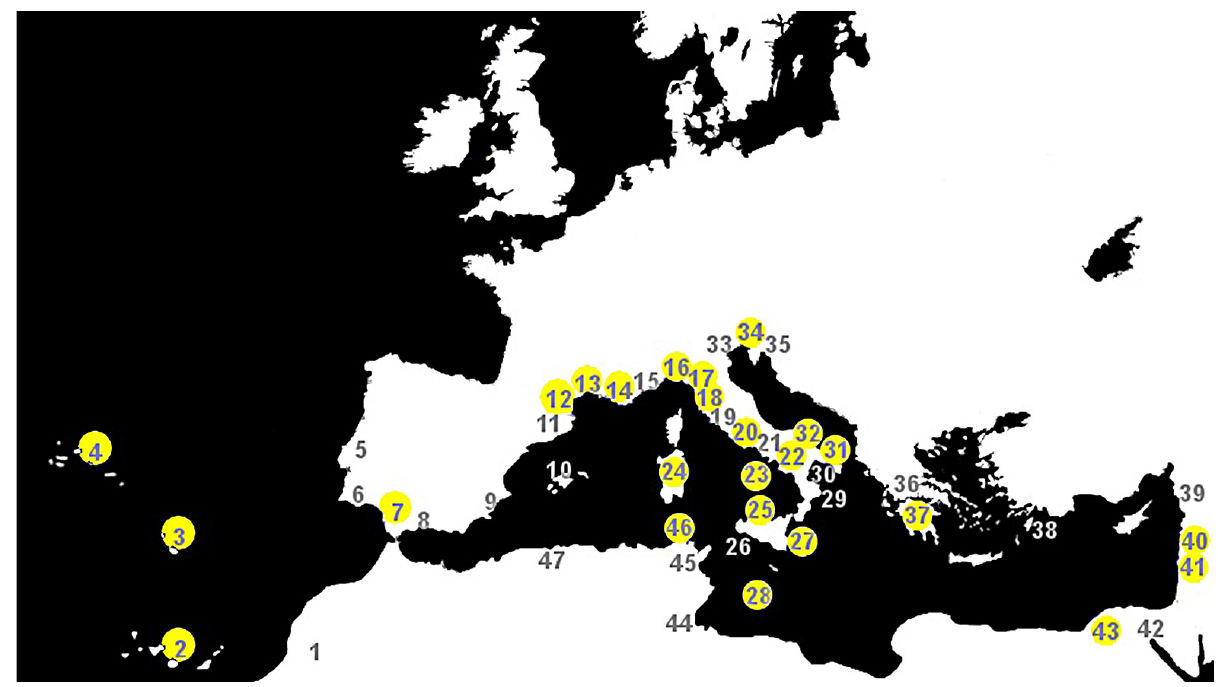
Fig. 5. – Known distribution of Amathia verticillata in the Mediterranean Sea and NE Atlantic. Records from harbours and marinas high- lighted with circles. Numbers of records refer to Table